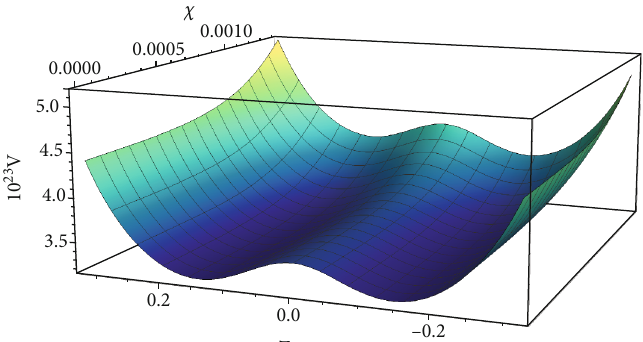
≃ ±0 : 144 . The min ≃ 2 : 43 × 10 − 6 , μ ≃ 2 : 858 × 10 − 11 , and κ = 0 : 56 , which are fi xed z zz